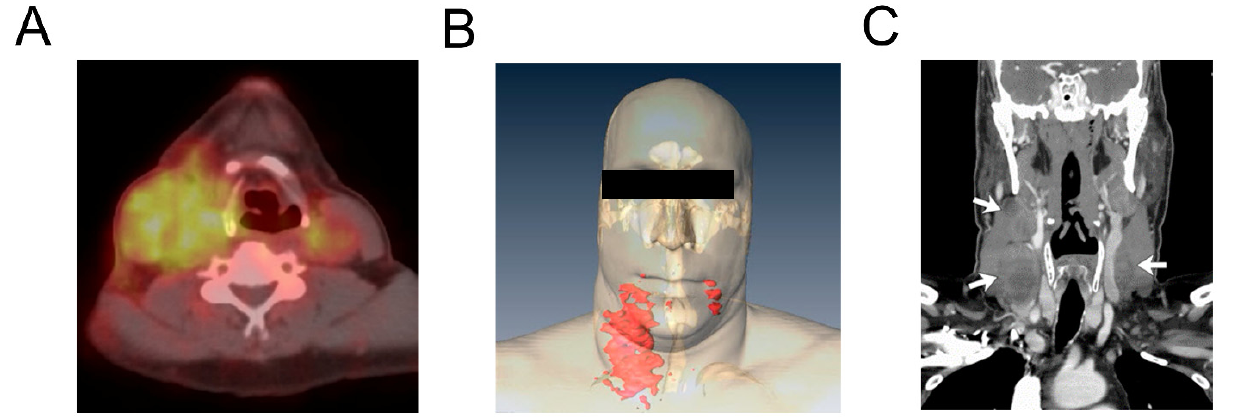
Figure 3. Cervical lymphadenopathy in a 46-year-old man with metastatic squamous cell carcinoma that originated from the tongue base. ( A ) Displays an axial slice of [ 124 I]I-NM404 PET overlaid on the CT volume. ( B ) Shows an isosurface representation of the tumor volume. ( C ) Coronal CT slice with white arrows indicating squamous cell carcinoma.